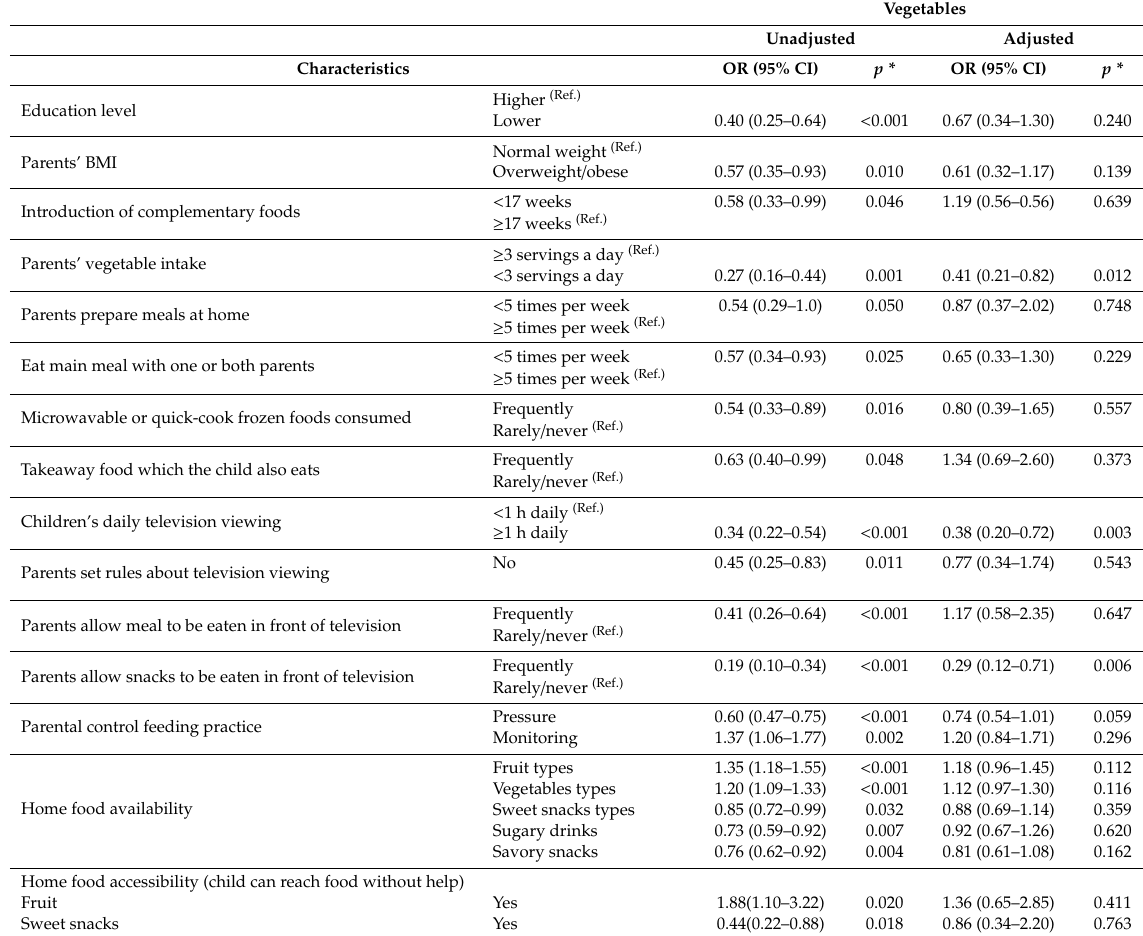
Table 5. Home environmental characteristics associated with children’s vegetable